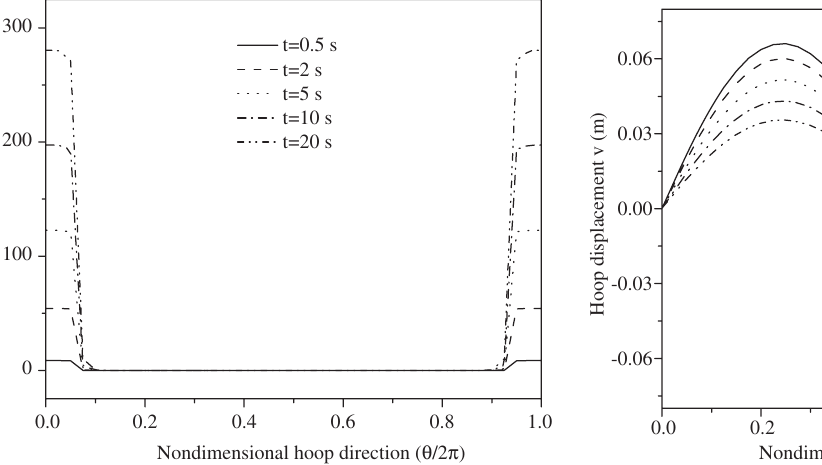
Figure 17 Distributions of temperature along the hoop direction of the FGM hollow cylinder at different times.